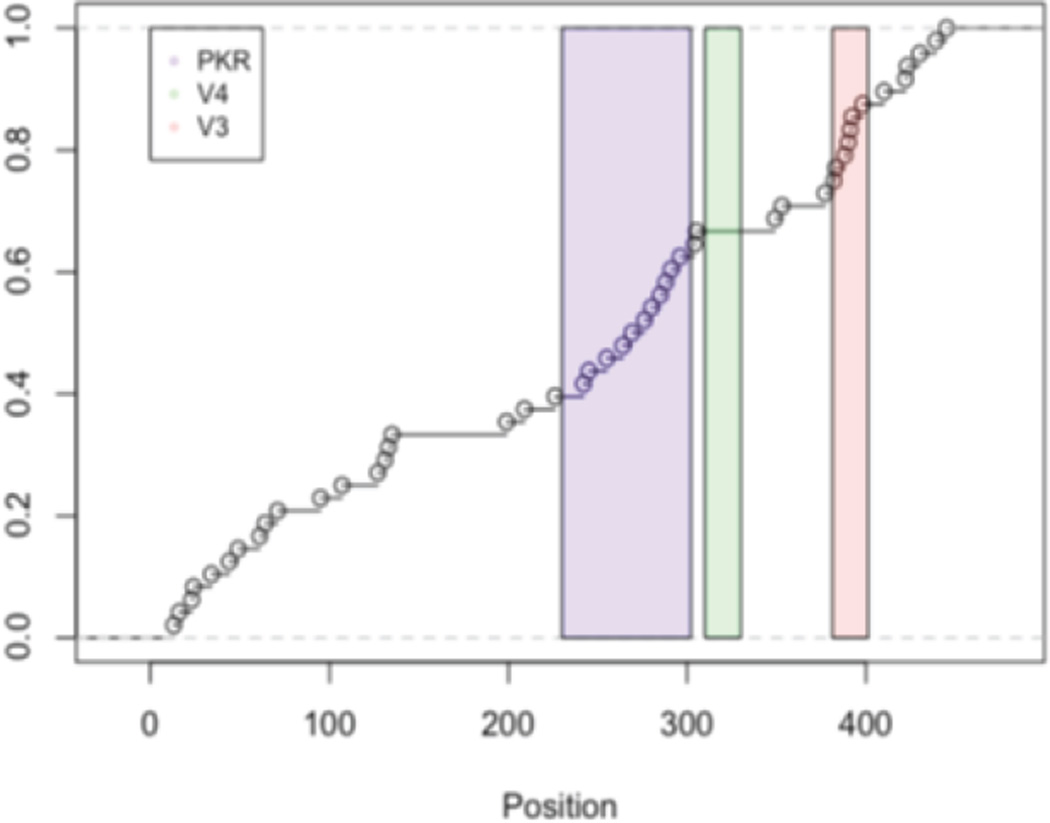
Summary for Table 3